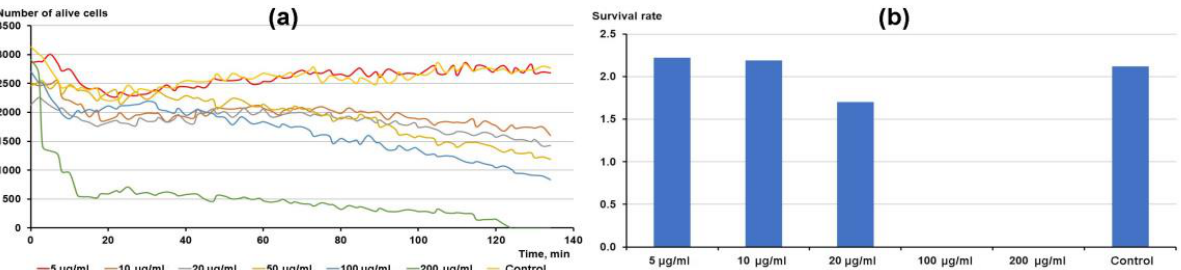
Figure 5. The toxicity of fraction IV-18-2 to Tetrahymena . ( a ) Short-time experiment. ( b ) 24 h experi- ment. Survival rate is the ratio of the number of live ciliates after 24 h of incubation to the number of ciliates at the beginning of the experiment. Three independent measurements were performed for each concentration. For all concentrations, the coefficient of variation (CV) did not exceed 0.07, or 7% of the mean.